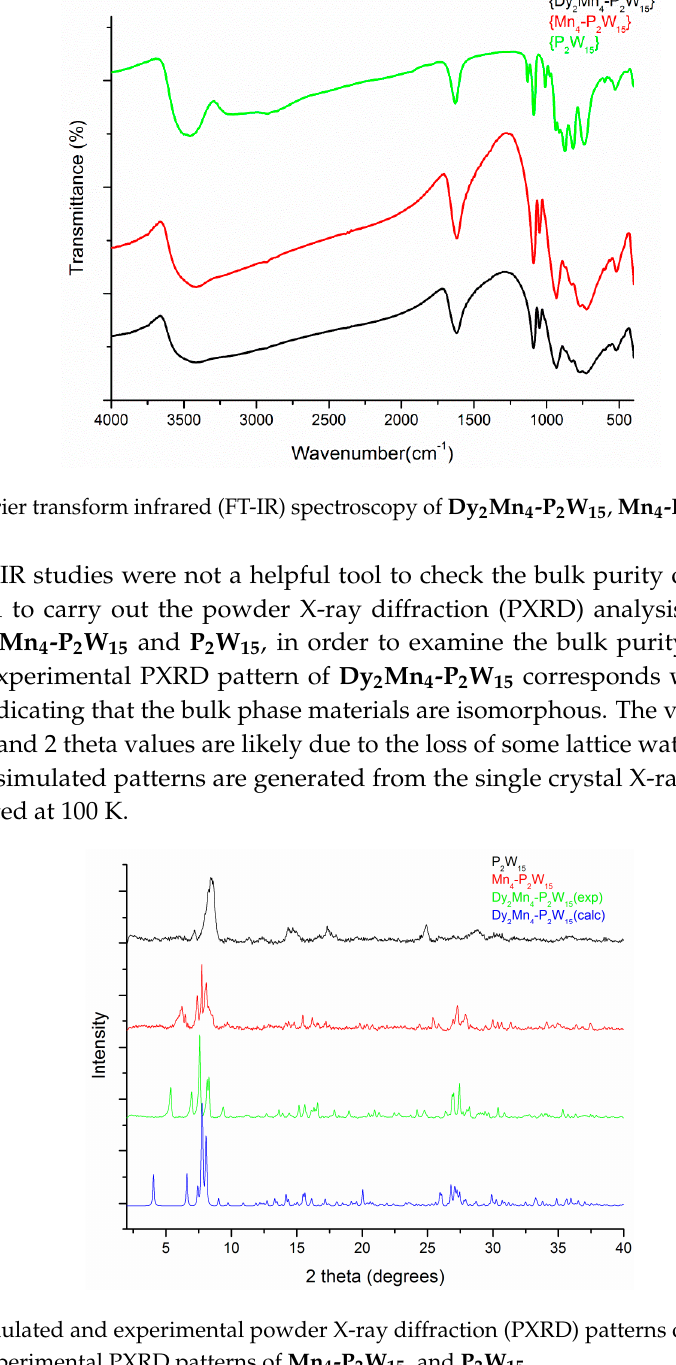
Figure 5. Stimulated and experimental powder X-ray diffraction (PXRD) patterns of Dy 2 Mn 4 -P 2 W 15 , along with experimental PXRD patterns of Mn 4 -P 2 W 15 , and P 2 W 15 .